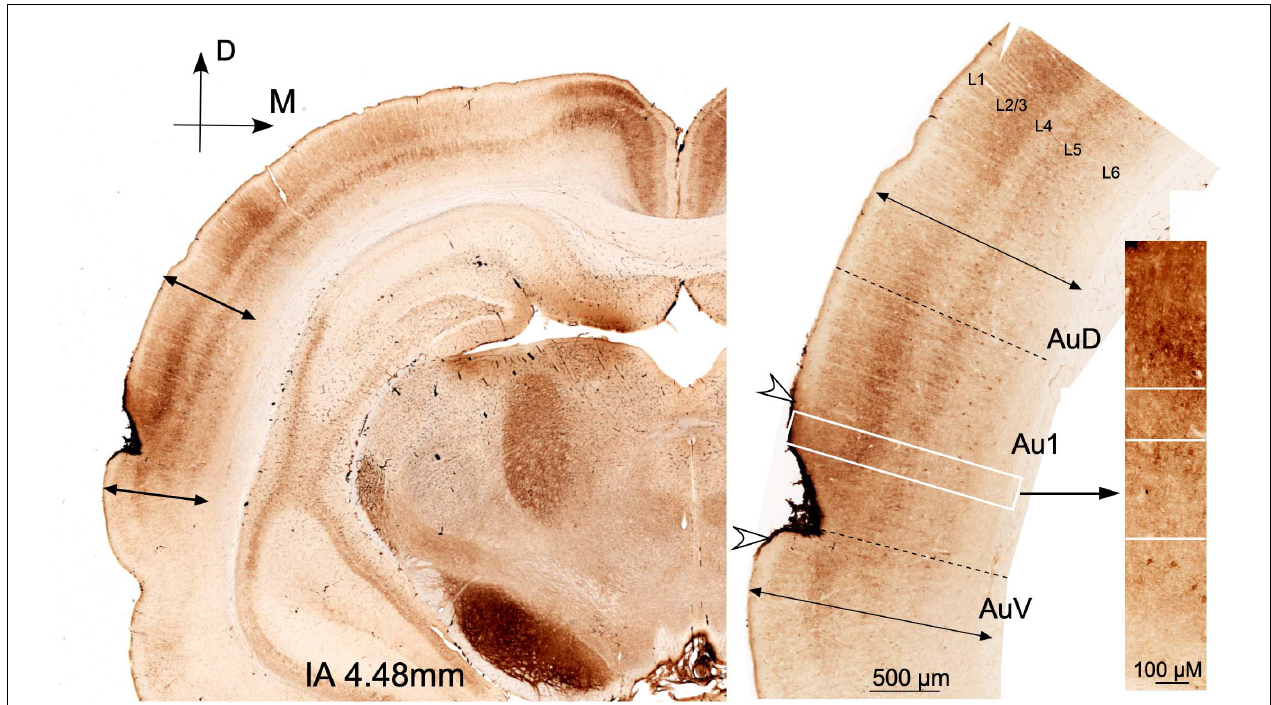
FIGURE 2 | Coronal sections at interaural 4.48 mm (Paxinos atlas coordinates) from a case from group ES euthanized at day 14 of the protocol (2 days after multisession epidural stimulation). GAD 67 dense reaction product in the surface of the cortex defines the position of the electrode. Arrowheads indicate the limits of the lesion in the coronal plane. The perimeter length of the reinforced area in the brain surface was 2.03 mm. Cytoarchitectural landmarks (double arrows) delimit the auditory cortex area. Note the well-defined immunoreactive layers and the well-preserved cytoarchitectural subdivisions in the non-damaged auditory area.